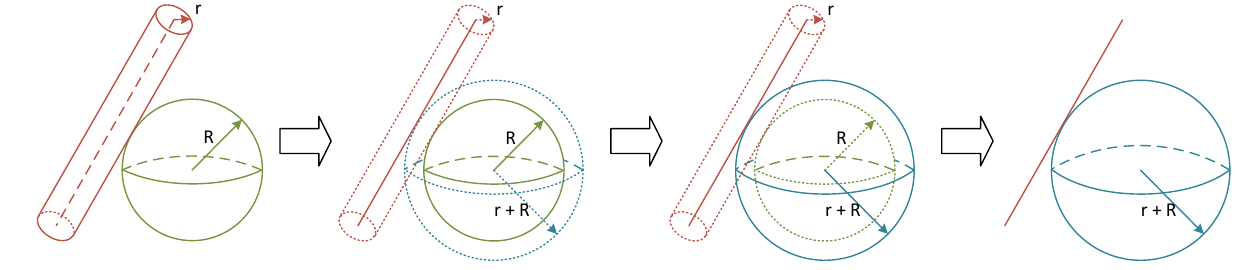
Figure 4. Arm Model Simplification Diagram.